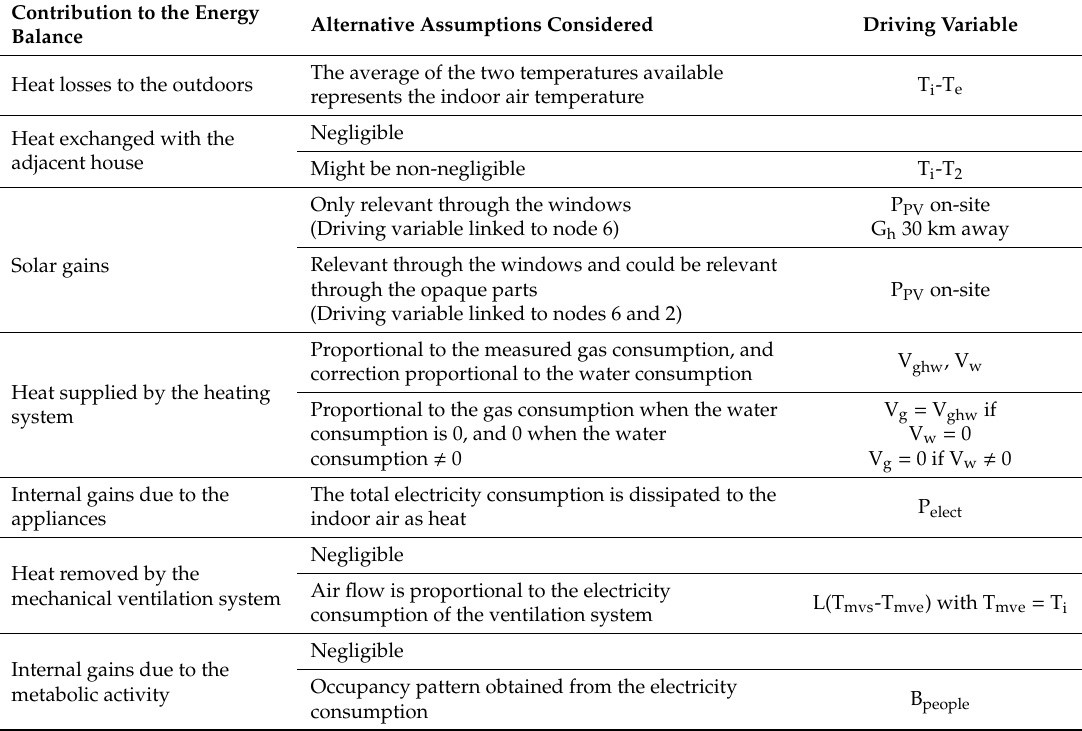
Table 1. Considered contributions to the energy balance and evaluated modelling alternatives.